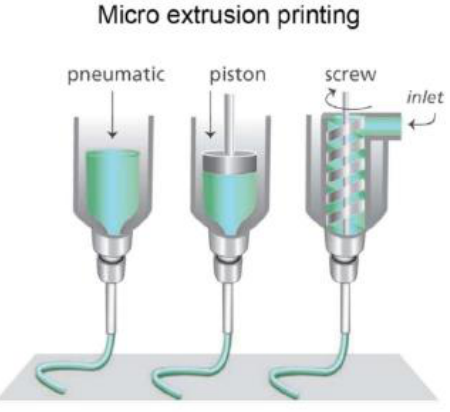
Figure 4. Three of the most common extrusion-based nozzles used for 3D printing (reprinted with permission from Malda et al.; copyright (2013) [86]). Hydrogels with suspended cells are inserted